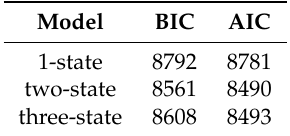
Table 1. Latent States